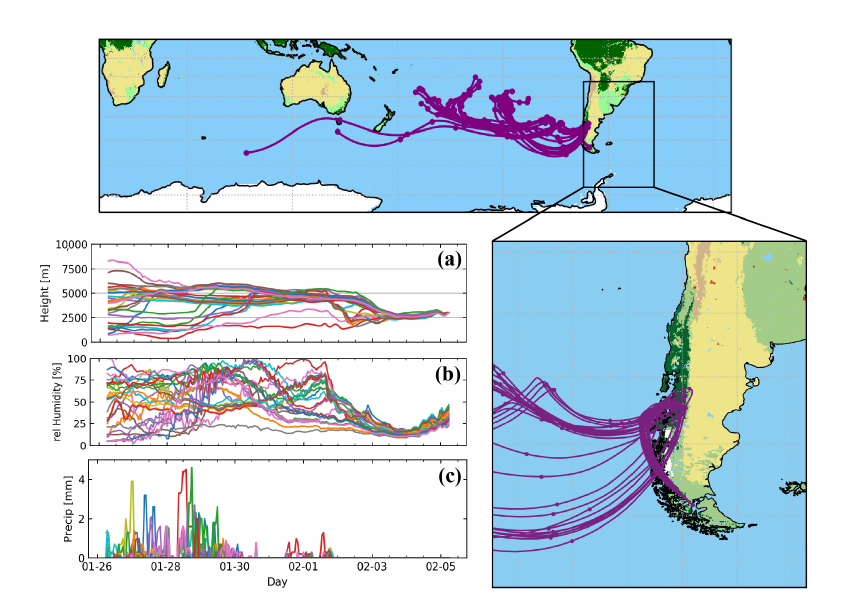
Figure 3. Top: the 10-day HYSPLIT backward trajectories ending at Punta Arenas, Chile, on 5 February 2019, 06:00 UTC, at 3 km altitude. ( a ) the altitudes (m) at which the air masses were traveling, ( b ) the relative humidities (%) of the air masses and ( c ) the precipitation in mm. Right: Zoom of top